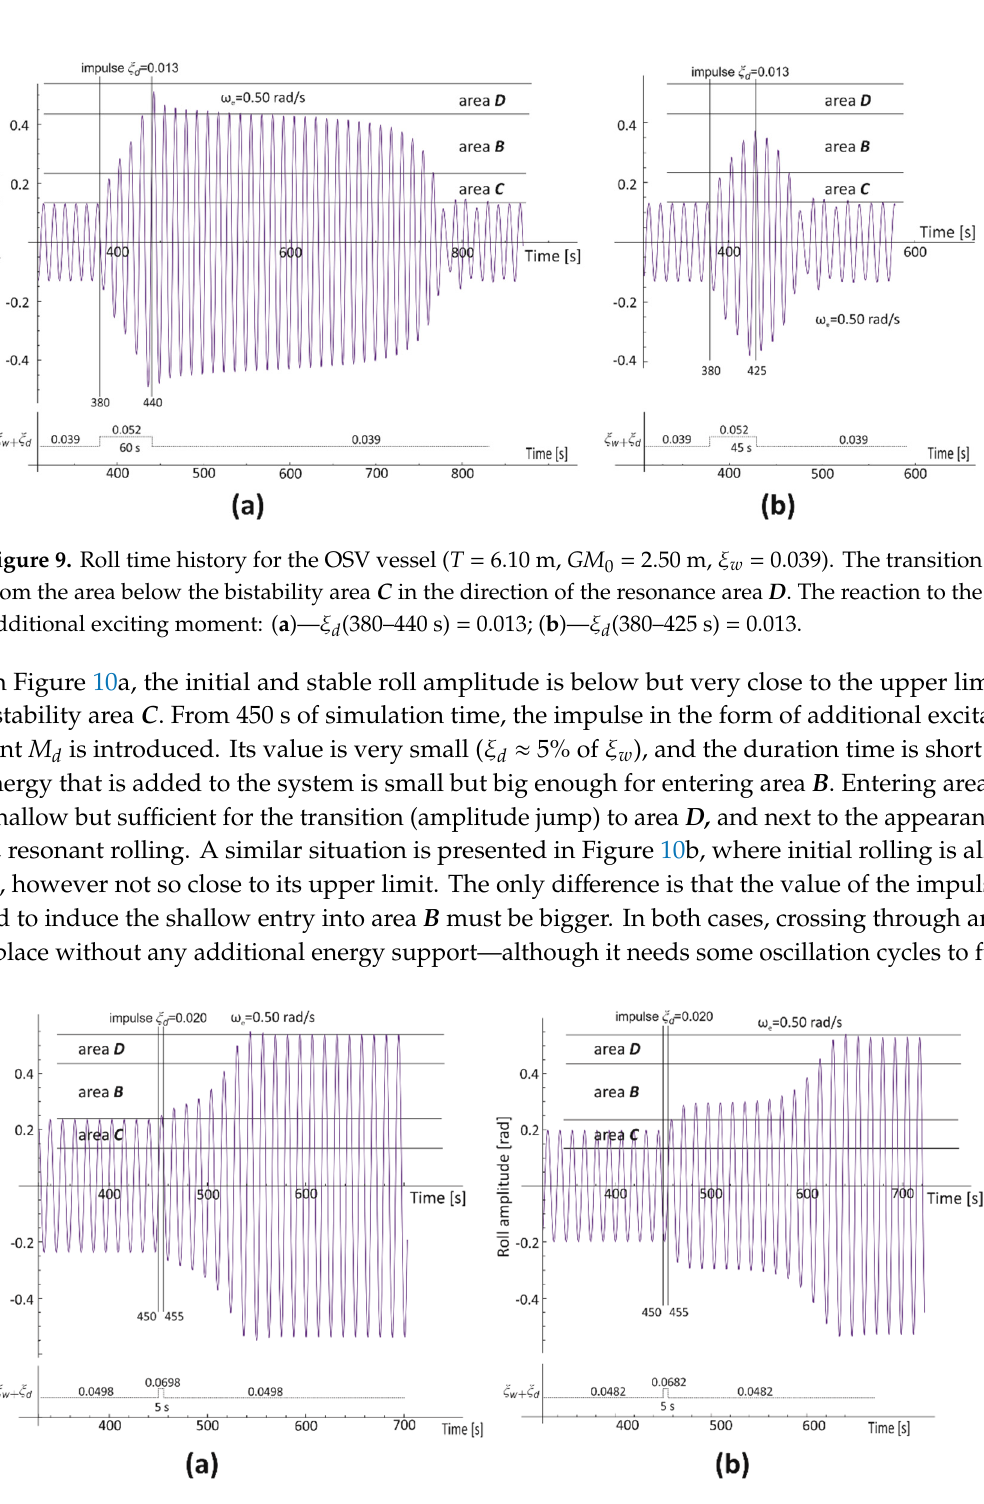
Figure 11. Roll time history for the OSV vessel ( T = 6.10 m, GM 0 = 2.50 m, ξ w = 0.044). The additional exciting moments: ξ d 1 (252–257 s) = ξ d 2 (400–405 s) = ξ d 3 (569–574 s) = 0.0345. Another fascinating case is presented in Figure 12, where the situation is similar to the one shown in Figure 10b. The difference is that during the crossing area B, from 600 to 615 s of the simulation, the additional impulse M d is introduced—its direction of action is opposite to M w . It can be seen that M d enforces the decrease of the amplitude of the oscillations and the direction of its return to area C . However, when M d is stopped, the amplitude of oscillations strives to area D afresh.